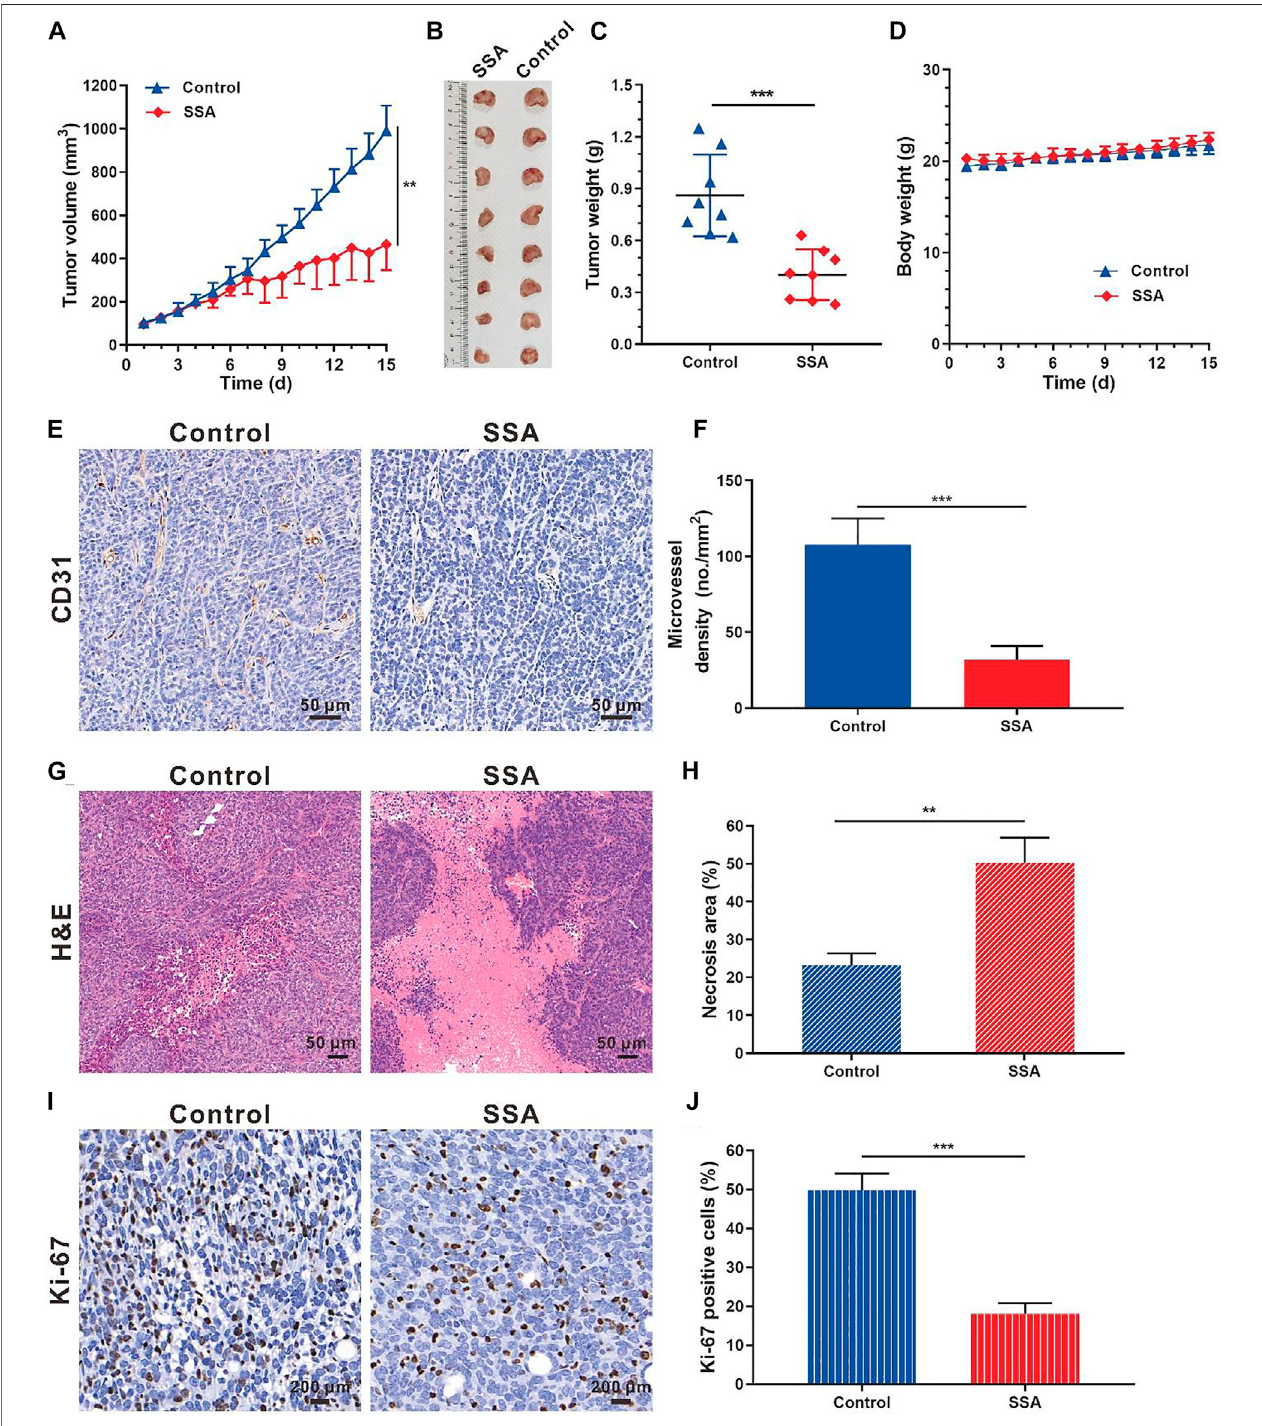
FIGURE5| SSAinhibitedorthotopic4T1tumorgrowthandangiogenesisinBALB/cmice.Whenthetumorgrewtoapproximately100 mm 3 ,themiceweretreated intraperitoneallywithsalineorSSA(10 mg/kg/day)forconsecutive15days. (A) Tumorgrowthcurve. (B) Photographsoftheexcisedtumoronday15. (C) Tumorweight onday15. (D) Mousebodyweightduringthetherapy. (E) RepresentativeimagesoftheimmunohistochemicalstainingofCD31 + tumorvessels. (F) Quanti fi edanalysisof tumor microvessel density (MVD). (G) H&E staining of the tumors showed the necrosis region. (H) Quanti fi ed necrosis area assay. (I) The brown nuclei of proliferativetumorcellswerestainedwithanti-Ki-67antibody. (J) StatisticalassayoftheKi-67positivetumorcellsinpanelI.Allvalueswereshownasmean ± s .d. n (cid:1) 8in A, C, and D. n (cid:1) 5 in F, H, and J. ** p < 0.01, *** p < 0.001. SSA suppressed angiogenesis and growth of subcutaneous HCT-15 tumors in mice.